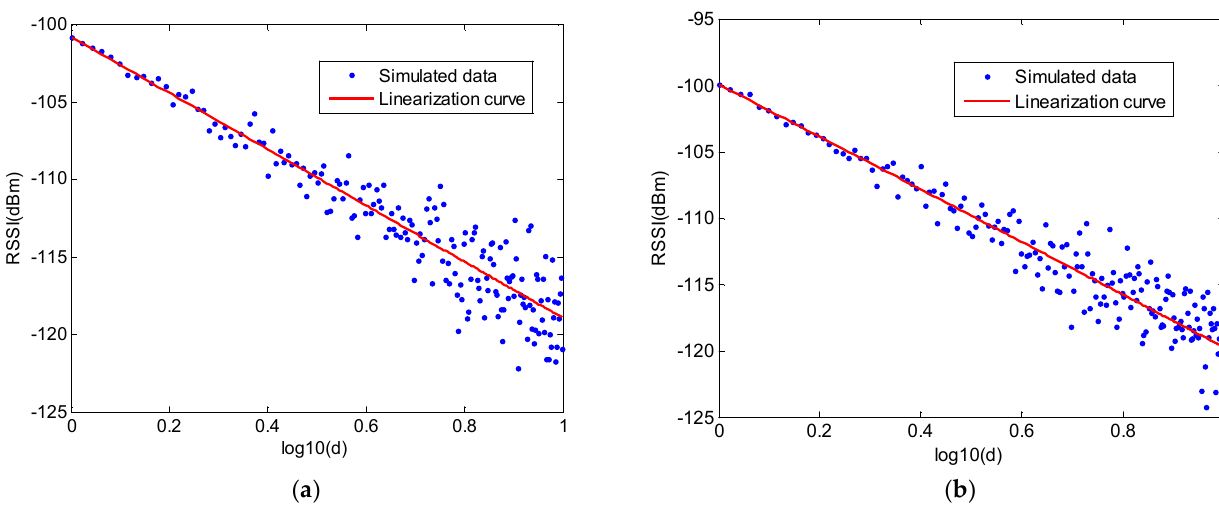
Figure 4. Interface of ray-tracing system.